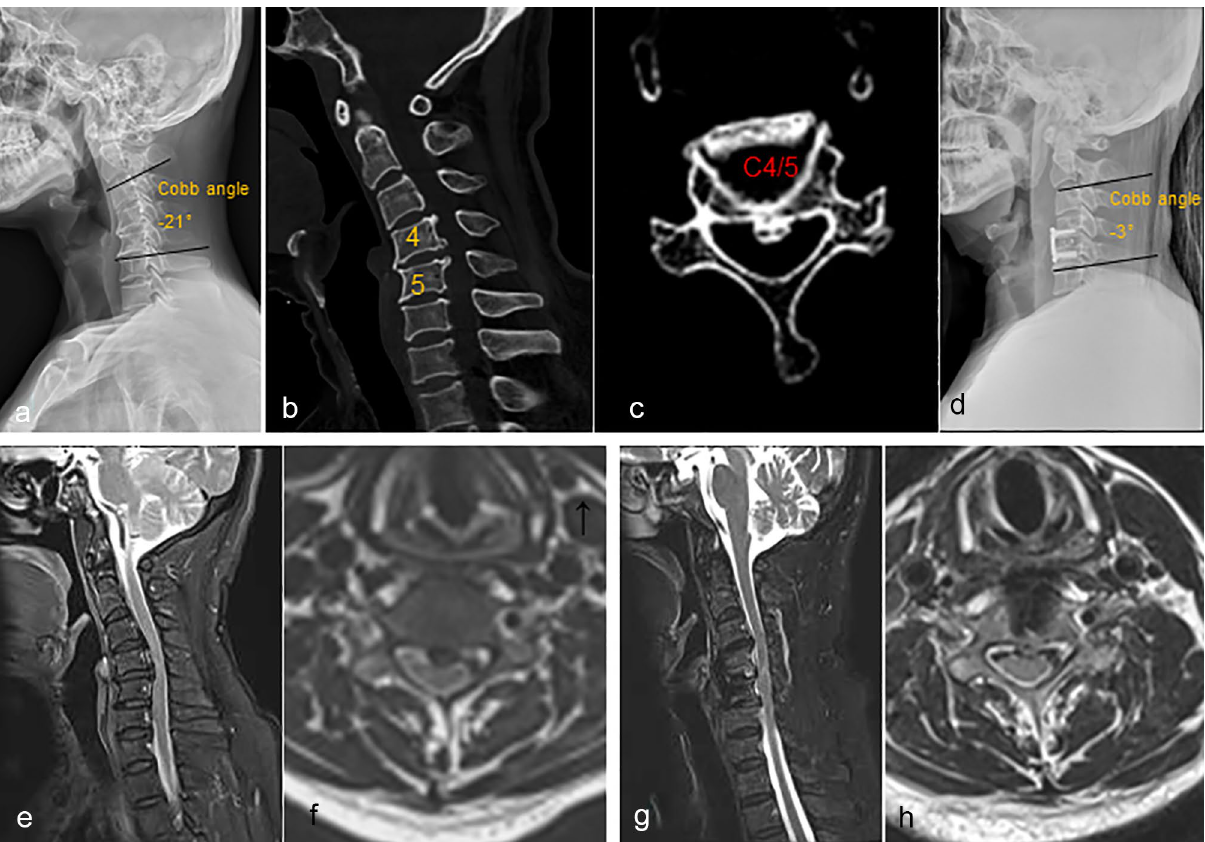
Figure 2. Case 25: a patients was 58 years, male, the walking unstable was main clinical symptom, the compression spinal cord due to herniation of intervertebral disc and cervical kyphosis, X-ray ( a ), CT ( b,c ) and MRI ( e,f ) before the ACDF. We performed single-level ACDF at C4/5, that decompressed spinal cord and corrected the cervical kyphosis ( d,g,h ). The walking unstable gradually improved during postoperative